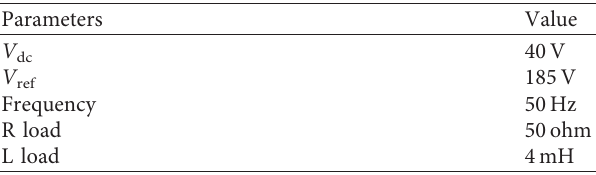
Table 5: Parameters for simulation.